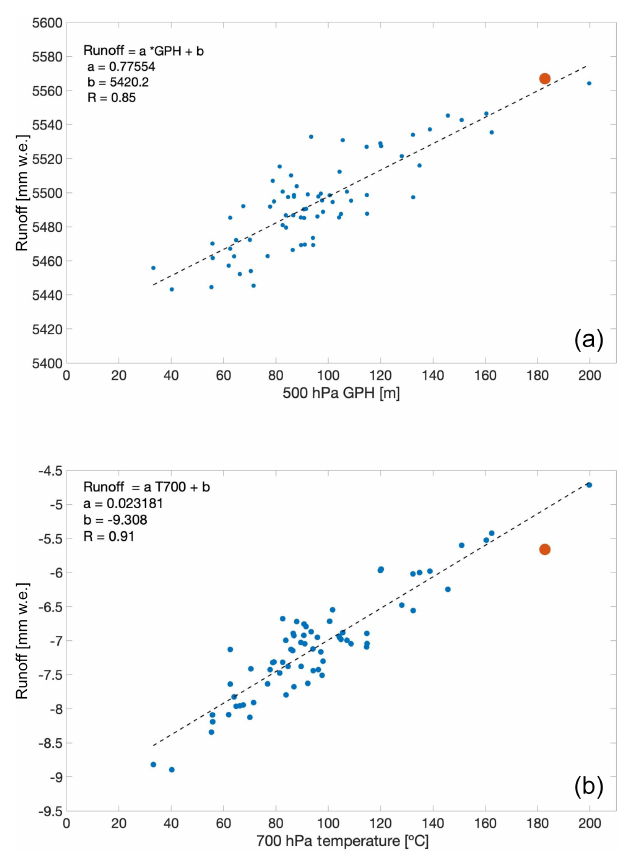
Figure 13. Scatterplot between runoff (mmw.e.) and (a) 500hPa GPH (m) and (b) 700hPa temperature ( ◦ C). Red disks show 2019 values in both plots. The coefficient of a linear regression analysis are reported within each plot, together with the coefficient of deter- mination R